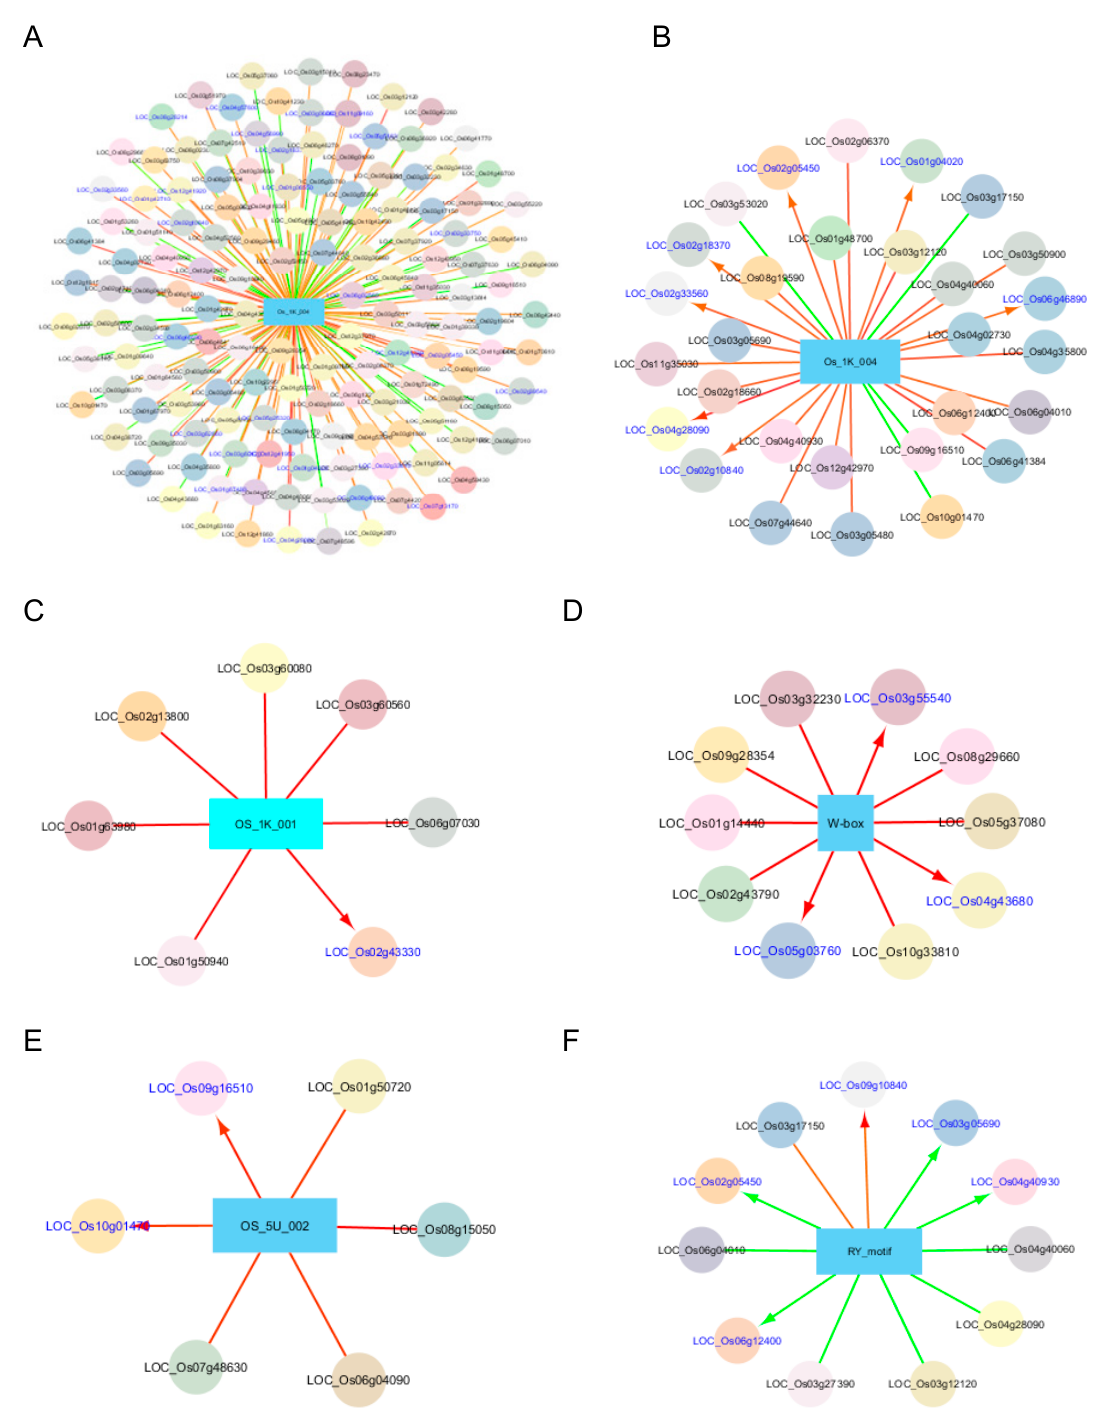
Figure 5. Selected CREs and their associated TFs. ( A ) The significantly associated TFs with OS_1K_004; ( B–F ), the associated TFs (R ≥ | 0.45 | ) with OS_1K_004, OS_1K_001, W-box, OS_5U_002, and RY_motif, respectively. The rectangular shape represents the CRE with its name labeled; circles, the associated TFs with the CRE with the gene name labeled; color of circles, di ff erent classes of TFs; red line, positive correlation; green line, negative correlation; thickness of line, the degree of correlation (in proportion to the thickness); arrow head and blue labeling, gene with the CRE in its 1-kb upstream sequence from the transcription start site.